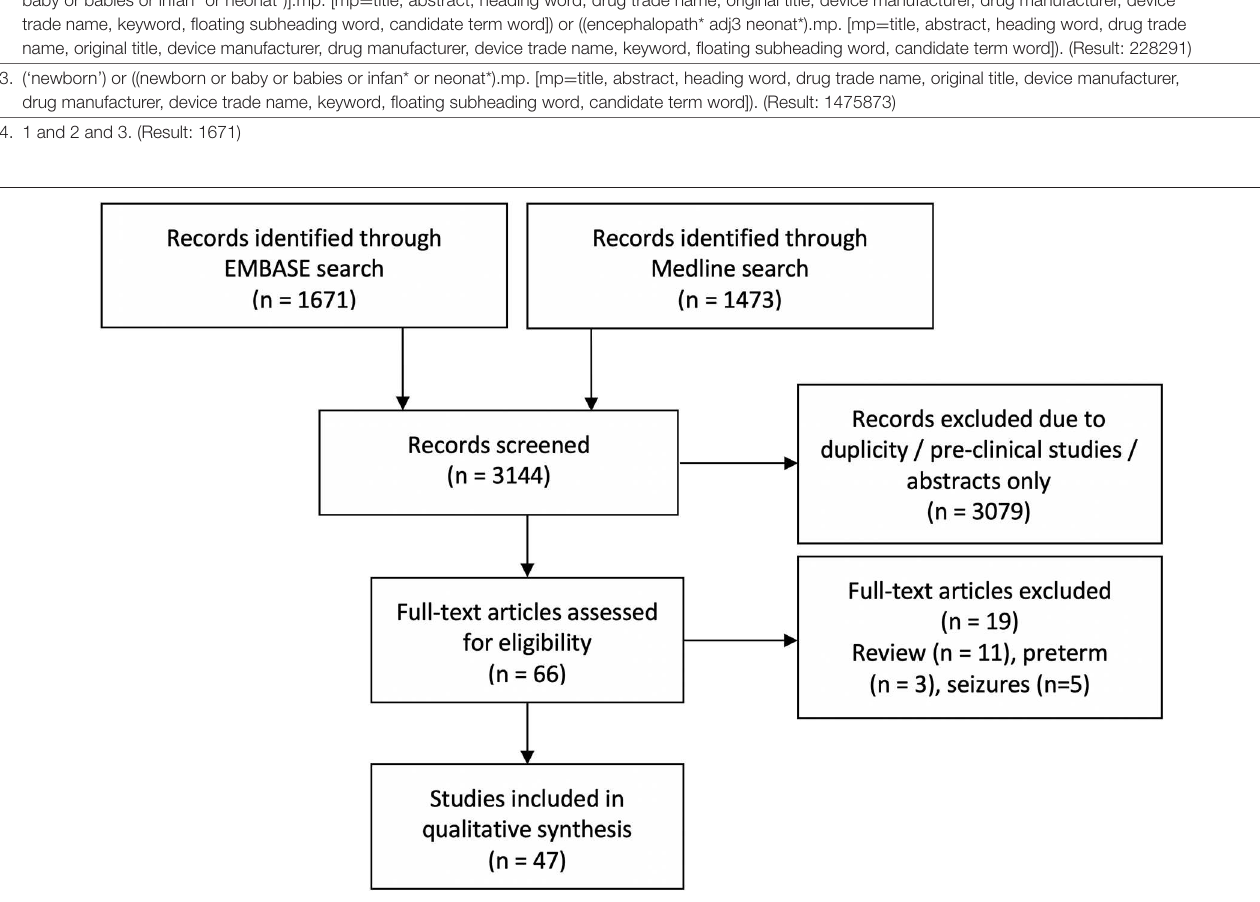
FIGURE 1 | PRISMA flow chart for the systamatic review.